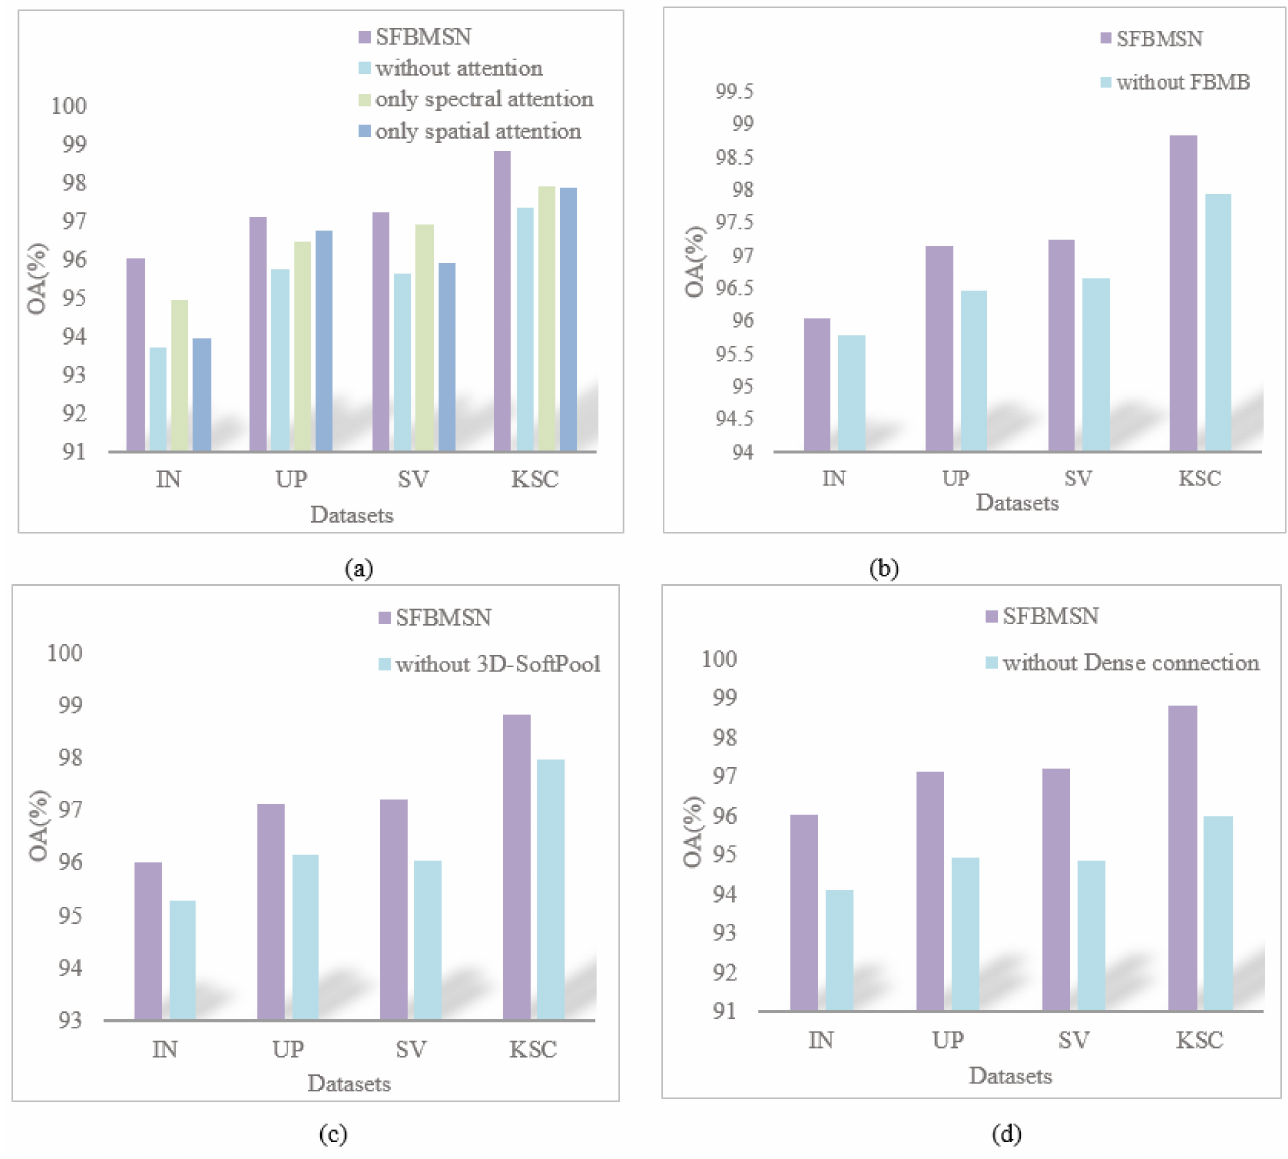
Figure 11. Ablation experiments of three modules of the proposed method on different data sets: